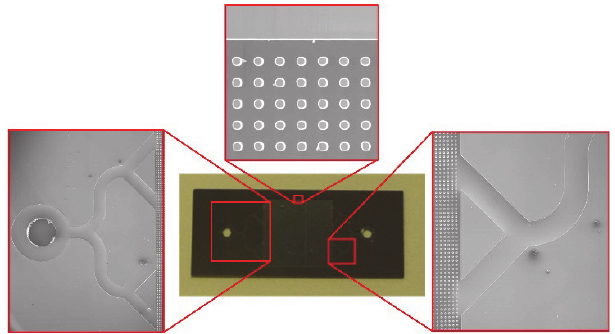
Fig. 2: Photo of patterned substrate showing microfluidic system. Insets: SEM images of sections of microfluidic system: (left) inlet; (center) micropillars; (right) microfluidic channels).